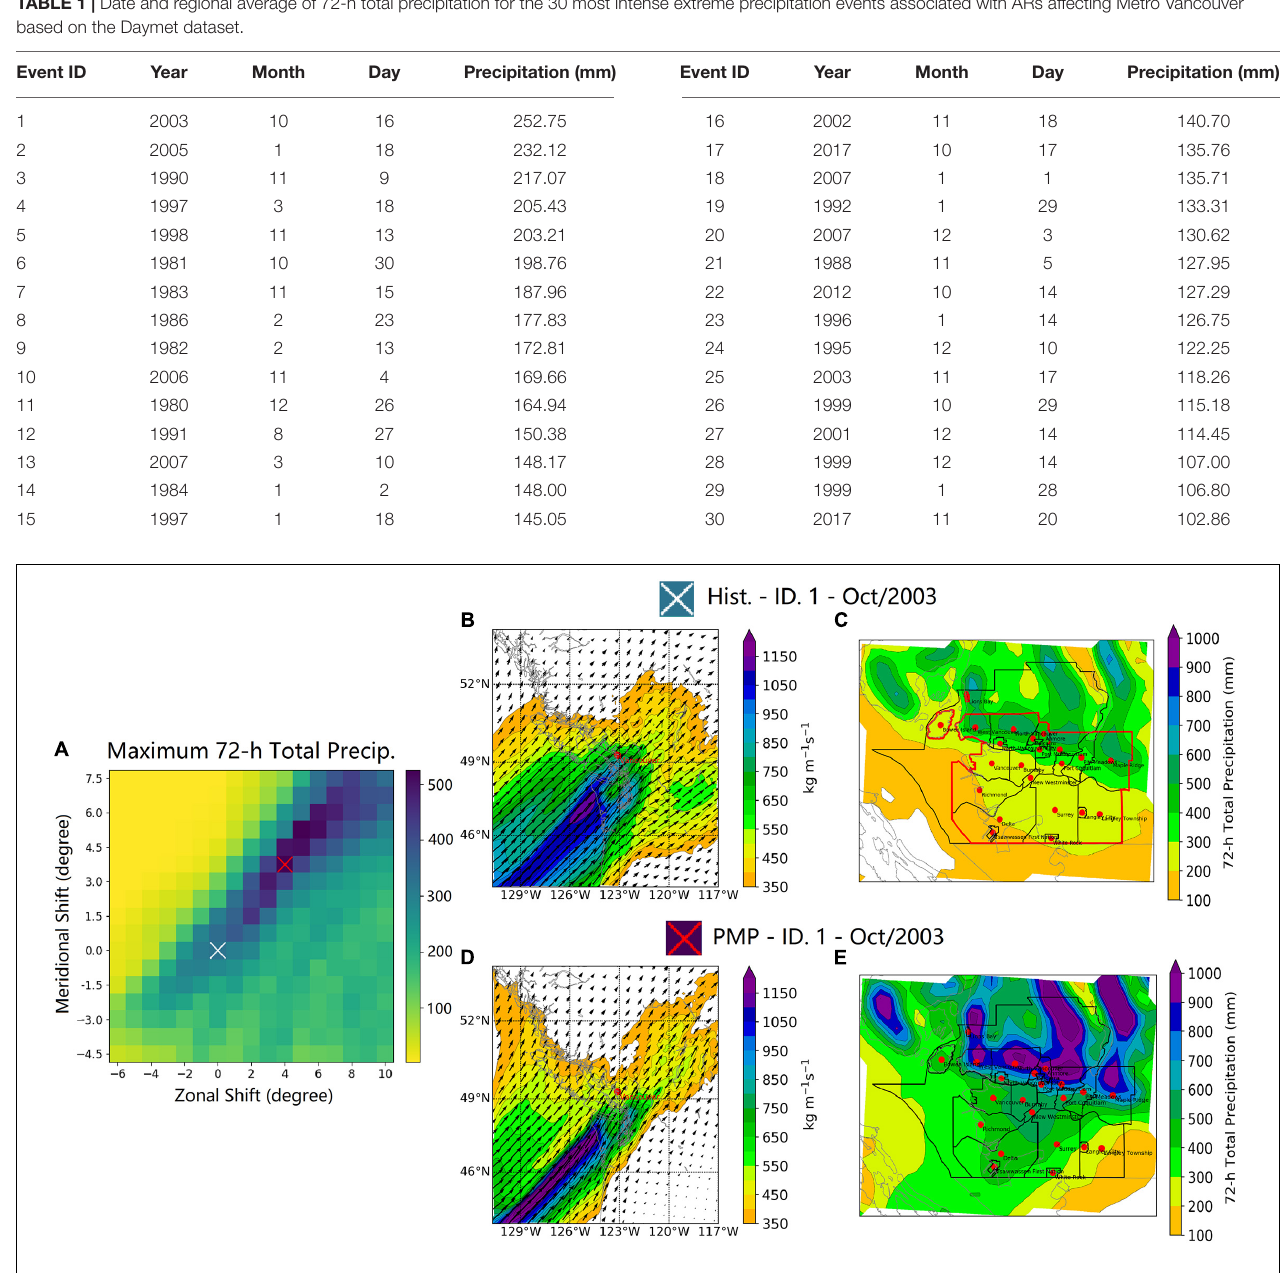
FIGURE 2 | The GEMCLIM simulations for the most intense extreme precipitation event over Metro Vancouver (occurring in October 2003) for the period 1980 ∼ 2017: (A) The distribution of regionally averaged maximum 72-h precipitation across different spatial shifts of LBCs; (B) the simulated historical IVT field (10-km simulation) when the maximum 72-h precipitation occurred during the event; (C) the simulated historical distribution of the maximum 72-h total precipitation (3-km simulation) during the event; (D) and (E) are as (B) and (C) but for the identified PMP simulation. For (A) , the white cross indicates the historical simulation (no LBC shifts) and the red cross indicates the LBC shifts corresponding with the PMP simulation.